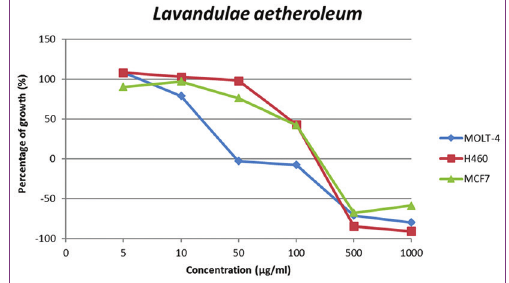
FIGURE 2. Growth inhibition of MOLT‑4, NCI‑H460 (H460) and MCF7 cells in vitro , assessed by 3‑(4,5‑Dimethylthiazol‑2‑Yl)‑2,5‑ diphenyltetrazolium bromide assay 72 hours after the addition of lavender essential